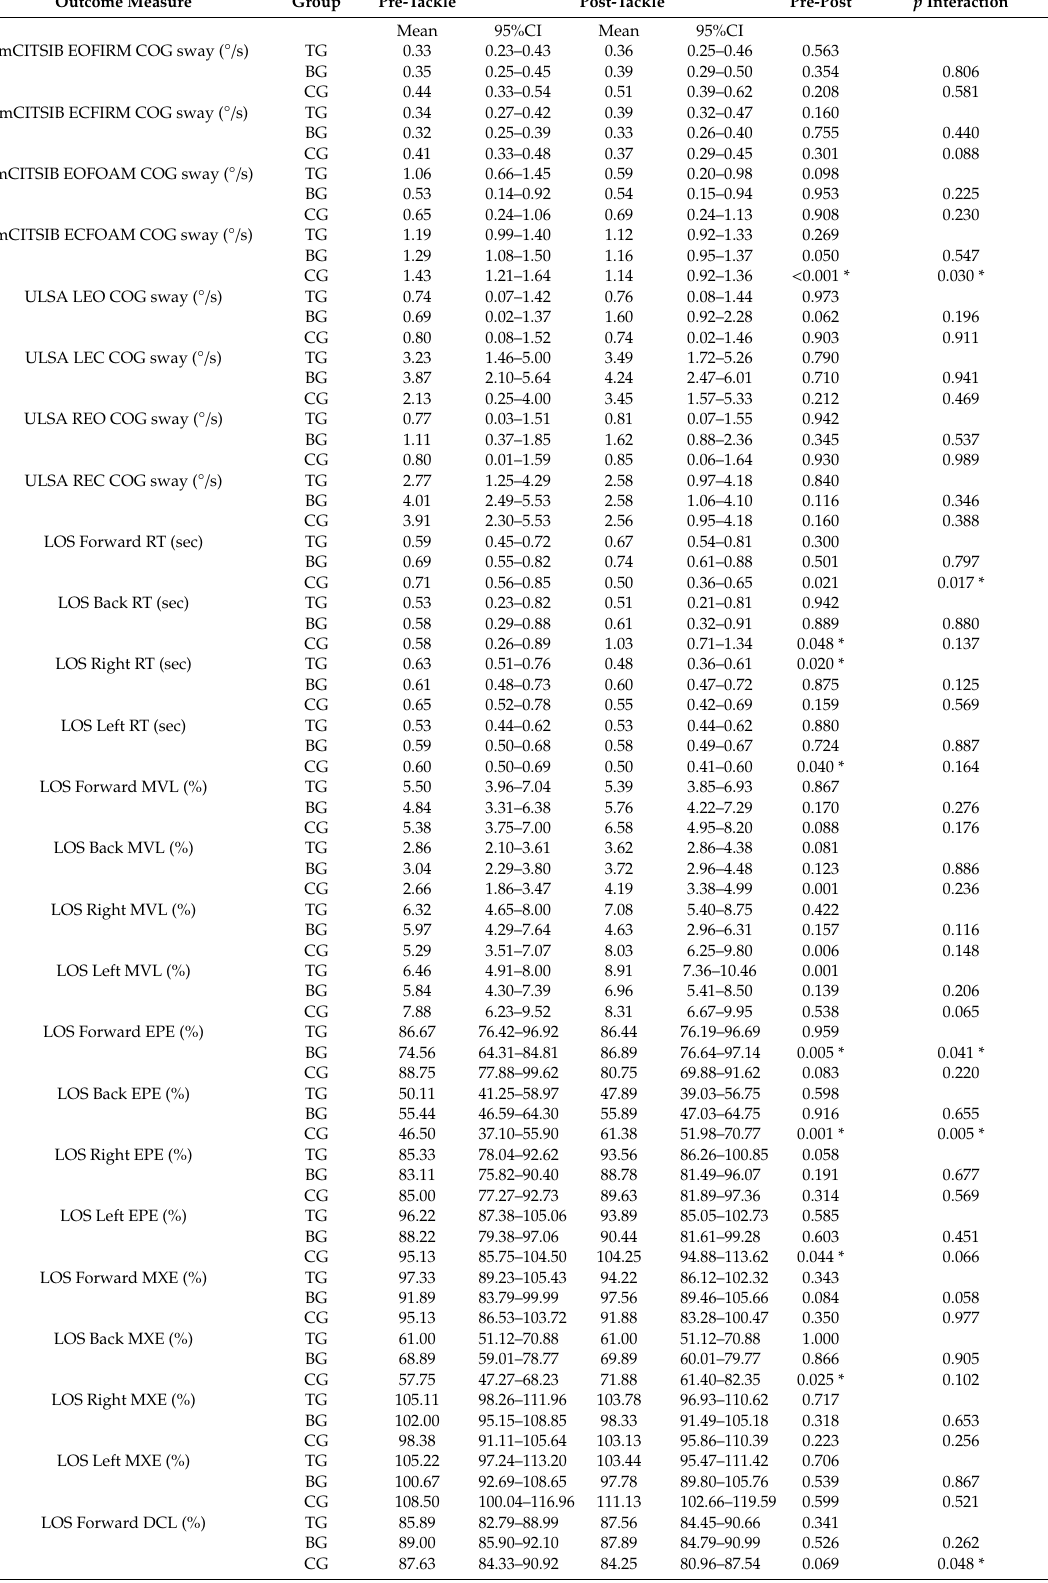
Table 3. Static and dynamic balance. Pre- and post-tackle marginal means with within and between group pre-post di ff